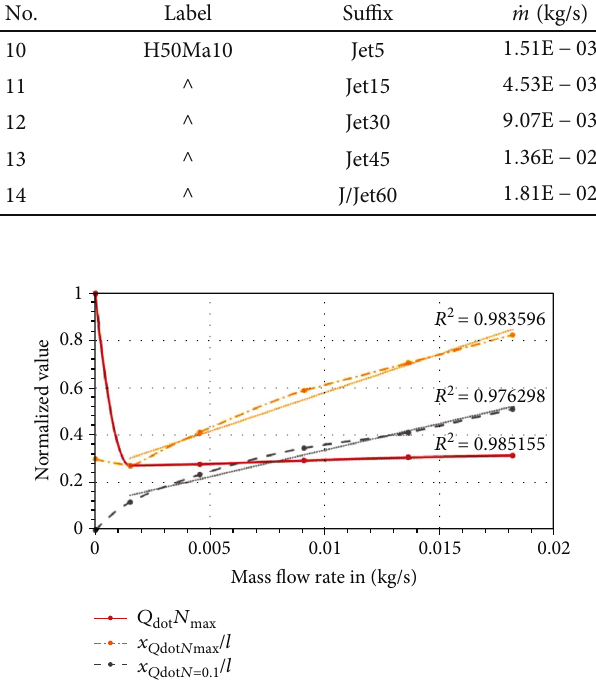
Figure 17: Plot of key indicators against _ m for the H50Ma10 series.